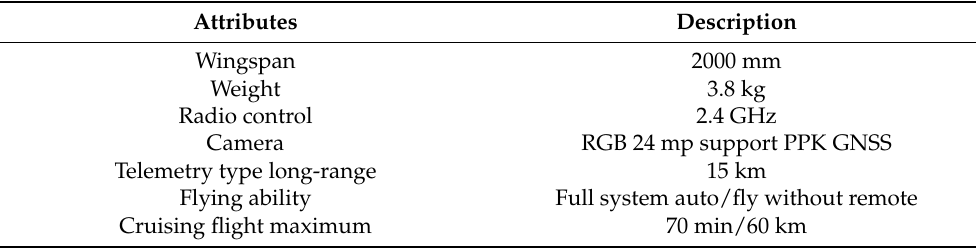
Figure 3. Fixed Wing VTOL drone. Table 1. Drone specifications.